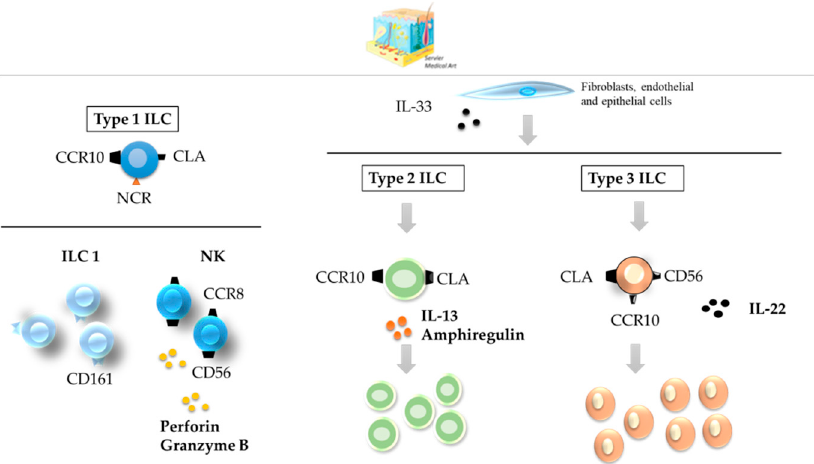
Figure 2. ILCs in the healthy skin. All three types of ILCs can be found in healthy skin; CD56 + CD16 − NK cells, ILC2s, and NCR( − ) ILC3s are the most abundant. All types of skin ILCs express the surface